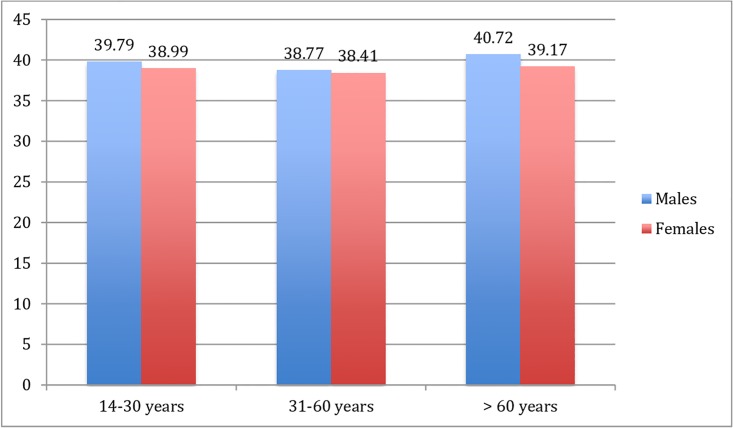
QMI total scores for age and gender groups.(males: n = 75 (14–30 years), n = 401 (31–60 years), n = 211 (> 60 years); females: n = 111 (14–30 years), n = 484 (31–60 years), n = 149 (> 60 years)).